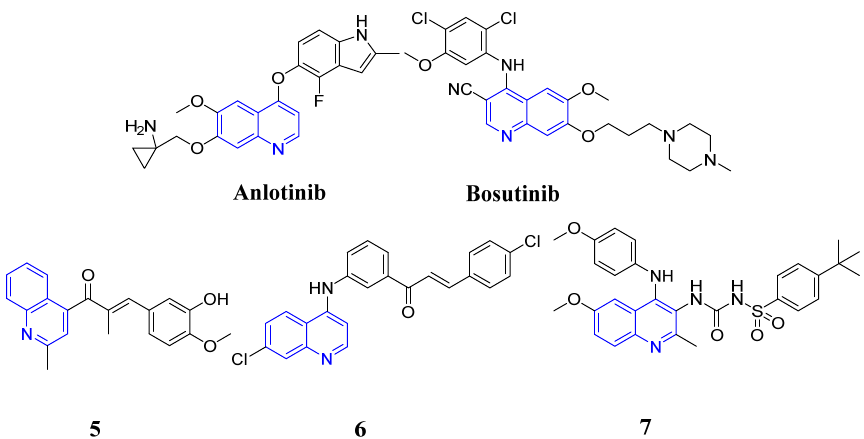
Figure 2. Structures of quinoline derivatives as anticancer agents previously reported.